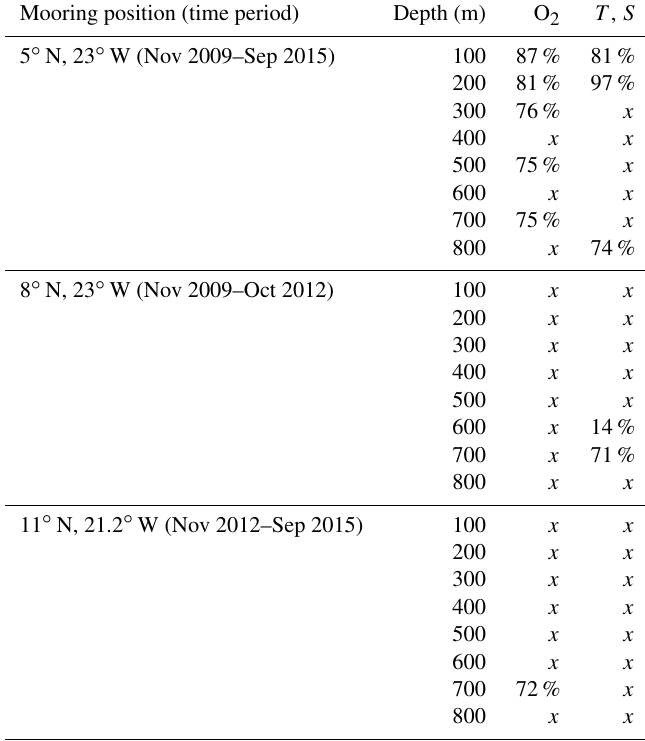
Table 2. Moored observations carried out in the eastern tropical North Atlantic between 2009 and 2015. Column “depth (m)” denotes the instrument depth at the respective mooring. Columns “O 2 ” and “ T , S ” denote the percentage of available oxygen and hydrographic data, respectively, compared to the total time period. A cross (“ x ”) marks data coverage of better than 99%. Mooring position (time period) Depth (m) O 2 T ,